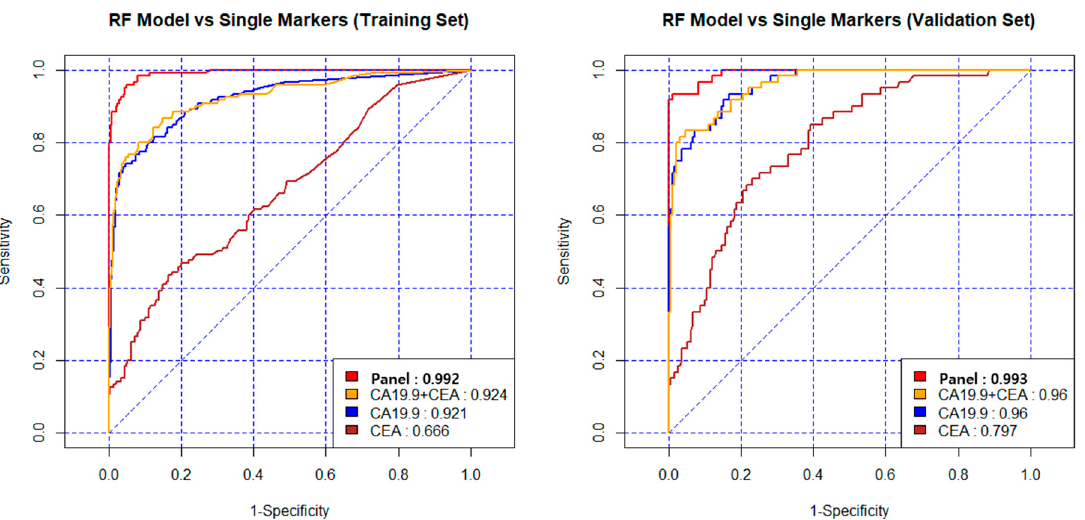
Figure 3. Diagnostic performance of the new model in the training set and validation set. The AUC was 0.992 in the training set and 0.993 in the validation set. Comparing CA19-9, CEA, and the combination of CA19-9 and CEA, the AUC of the new model was 0.993 in the validation set, and the AUC of CEA+ CA19-9 was 0.960 and CA19-9 alone was 0.960.